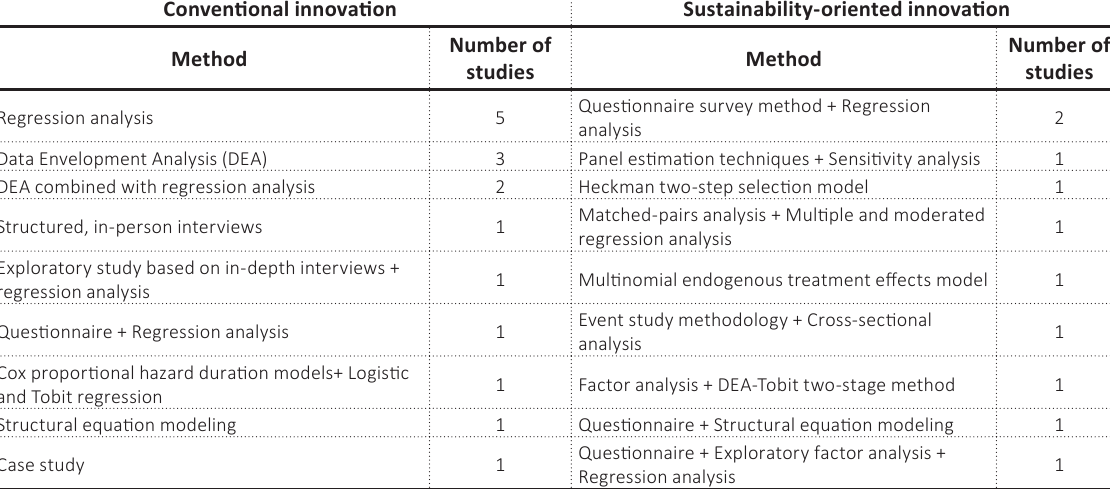
Source: Compiled by the